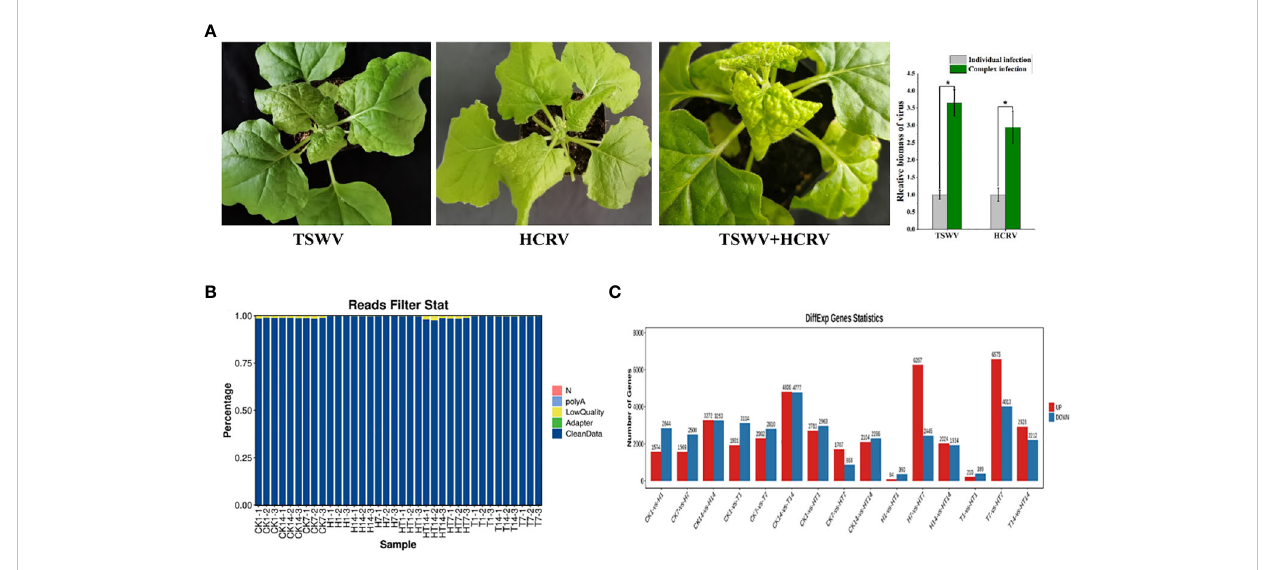
FIGURE 1 Overview of transcriptome pro fi les of Nicotiana benthamiana under different conditions. (A) Symptoms induced by viruses on tobacco seedlings. The biomass of HCRV and TSWV is determined using RT-qPCR. “ *: P < 0.05 ” . (B) The percentages of clean reads in each sample show the high quality of the transcriptome data used in this study. (C) The number of differentially expressed genes in each pairwise comparison. The red and blue columns show the signi fi cantly up and downregulated genes in each